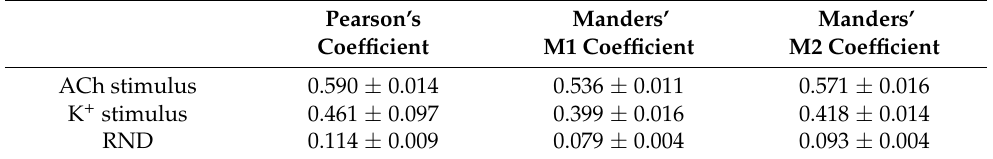
Table 1. Colocalization and overlapping coefficients between DBH and α 3 β 4 nAChR (endogenous and randomly simulated) after both secretion stimulus protocols. We used one-way ANOVA (Kruskal– Wallis non-parametric test) and Dunn’s Multiple comparison test (See Section 4.7). All three